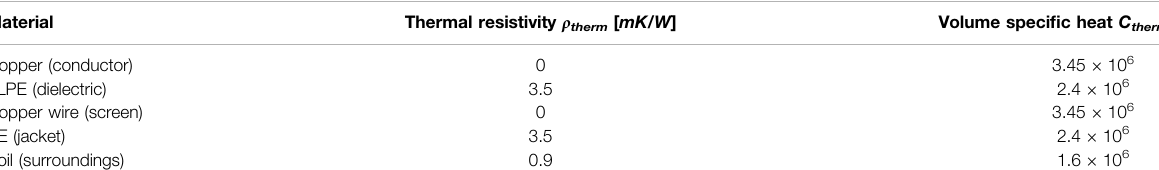
TABLE 3 | Thermal parameters in XLPE cables and